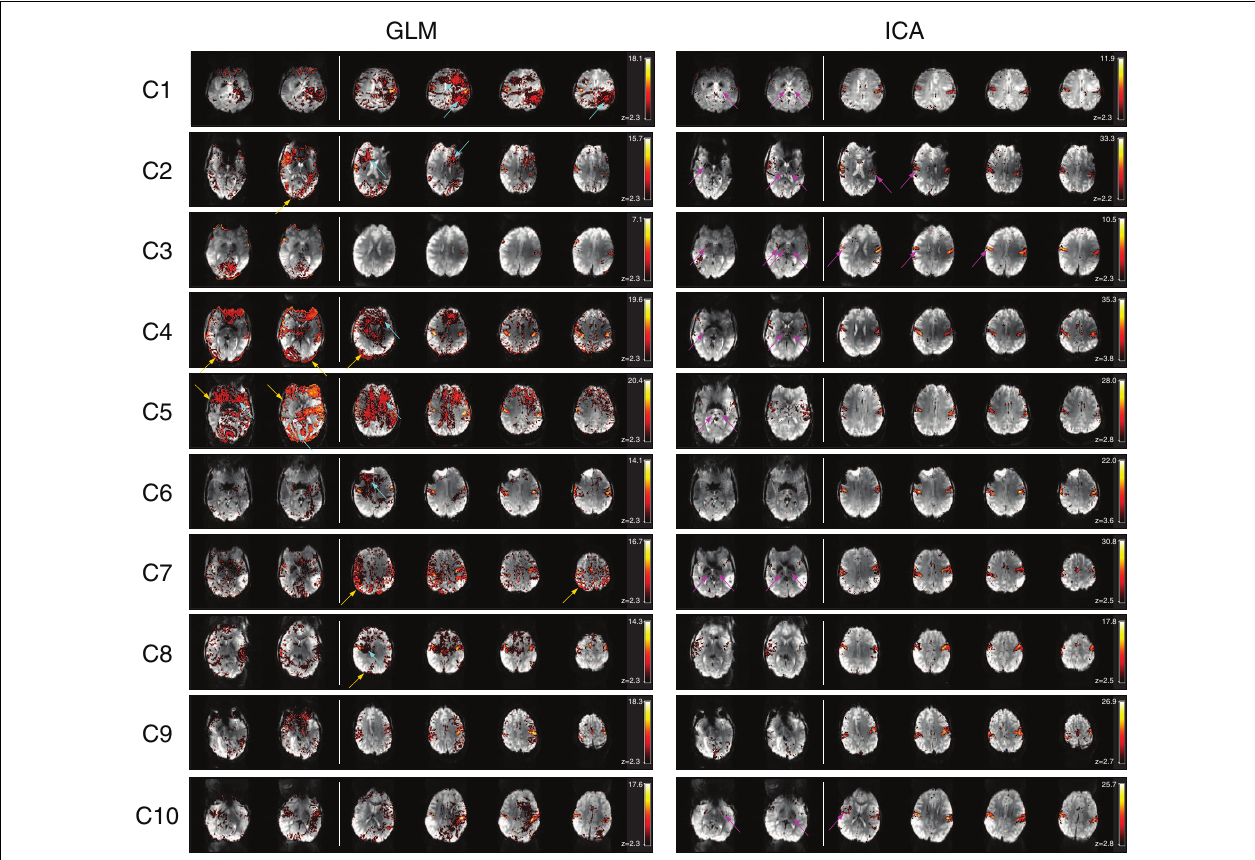
corresponding GLM results, or not distinguishable from artifacts, are indicated by magenta arrows.White vertical lines separate sample slices covering the basal ganglia from those showing primary motor regions. All brain images are displayed in radiological